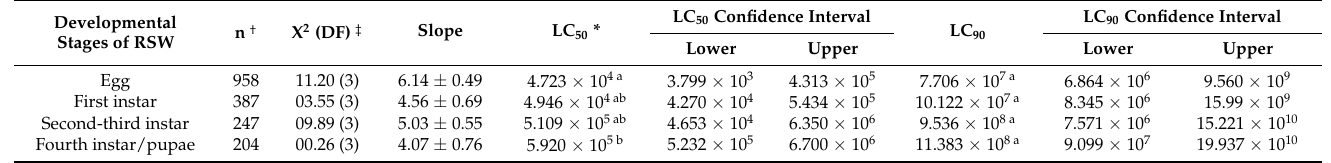
Table 1. Lethal concentration value of S. lanosoniveum against different developmental stages of RSW. Developmental Stages of